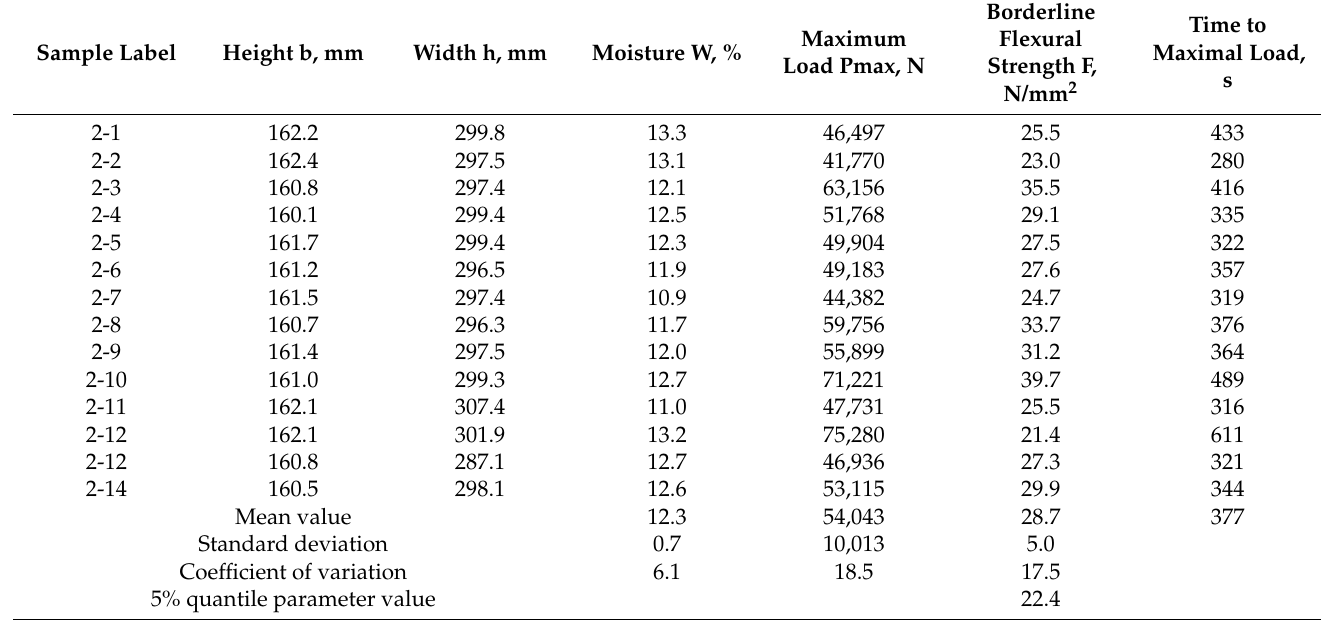
Figure 3. Borderline flexural strength N/mm 2 measurement graph for samples of group No. 1. 2. 2. Samples of group No. 2. Average size of the sample 161.30 × 298.20 mm 2 (see Table 2). Table 2. Characteristic values of borderline flexural strength, group 2 (load applied on the widest face).